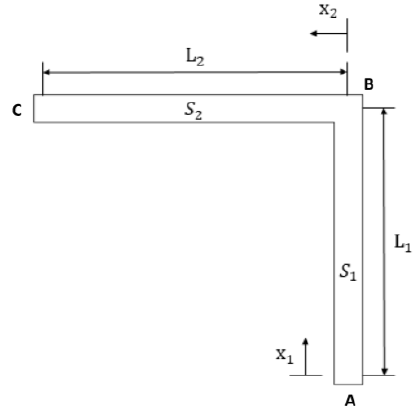
Figure 14. Top view of Part 1 of the coil.